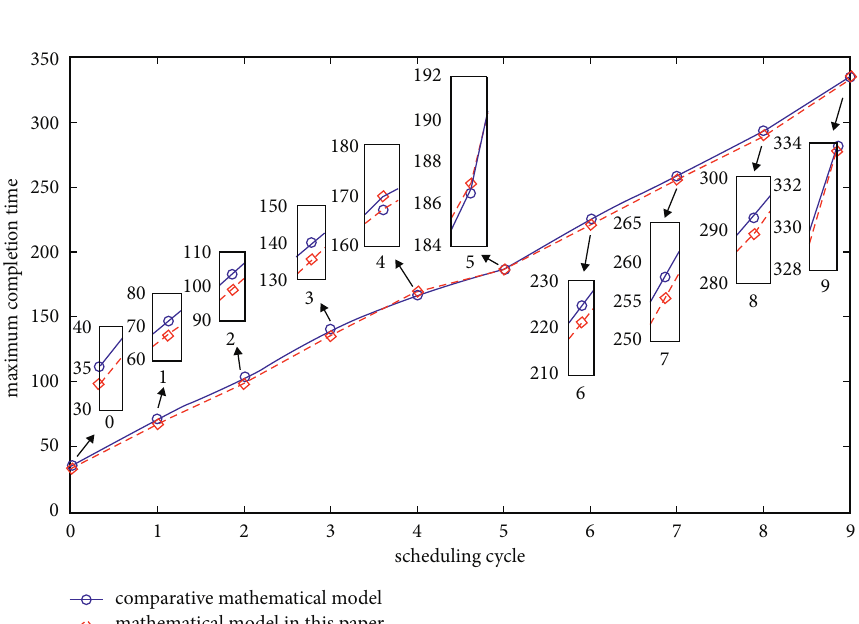
Figure 12: Comparison of the maximum completion time of each scheduling